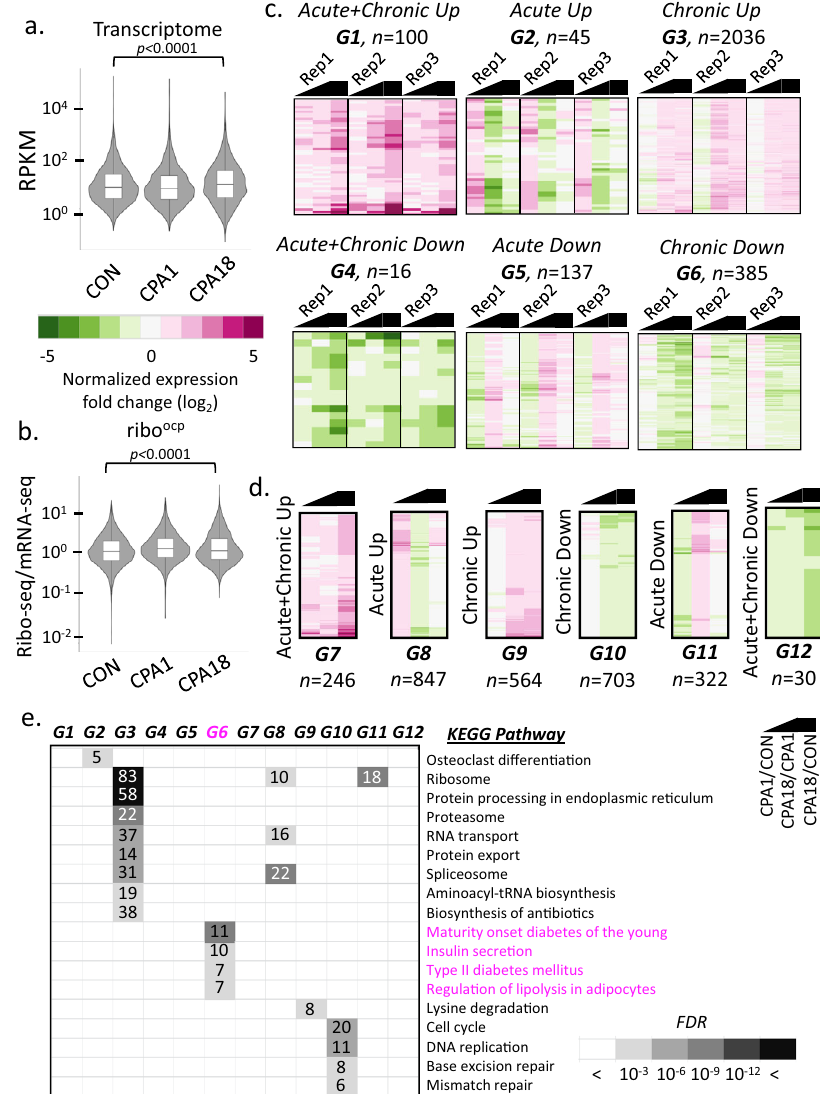
Fig. 3 | Analysis of transcriptomes and translatomes during progression from acute to chronic phase of ER stress in MIN6 cells. Violin plots representing transcriptomes ( a ) and translatomes ( b ), of untreated (CON), 1h CPA treated (CPA1) and 18h CPA treated (CPA18) cells. The boxes indicate the 25 – 75th per- centiles,themidlineindicatesthemedian,whiskersshowthemaximum/minimum. p -value represents the statistical test by two-sided Wilcoxon signed-rank test. Heatmapsandtheclassi fi cationsofchangesintheexpressionoftranscriptomes( c ) andtranslatomes( d )betweenCONandCPA1(CPA1/CON),CPA18andCPA1(CPA18/